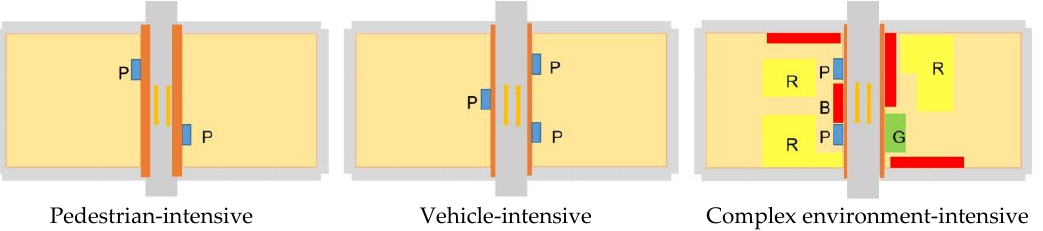
Figure 14. Location characteristics of entrances and exits to urban parking facilities. Note: P is for parking facilities; R is for residential use; B is for commercial use; G is for green space.